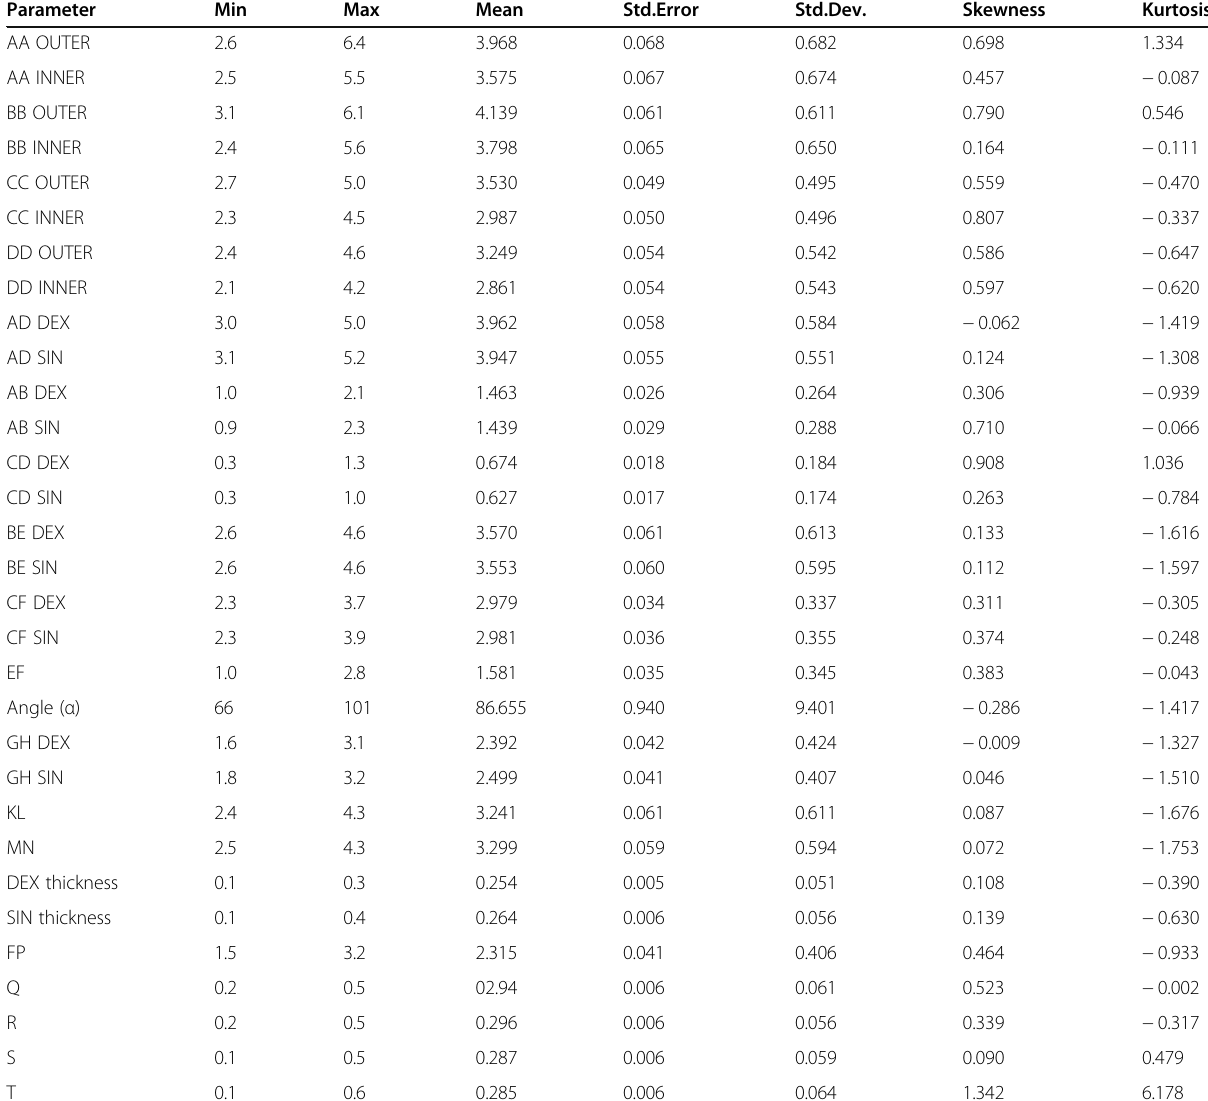
Table 5 The statistical parameters of angles and sizes, N = 100 (cm)